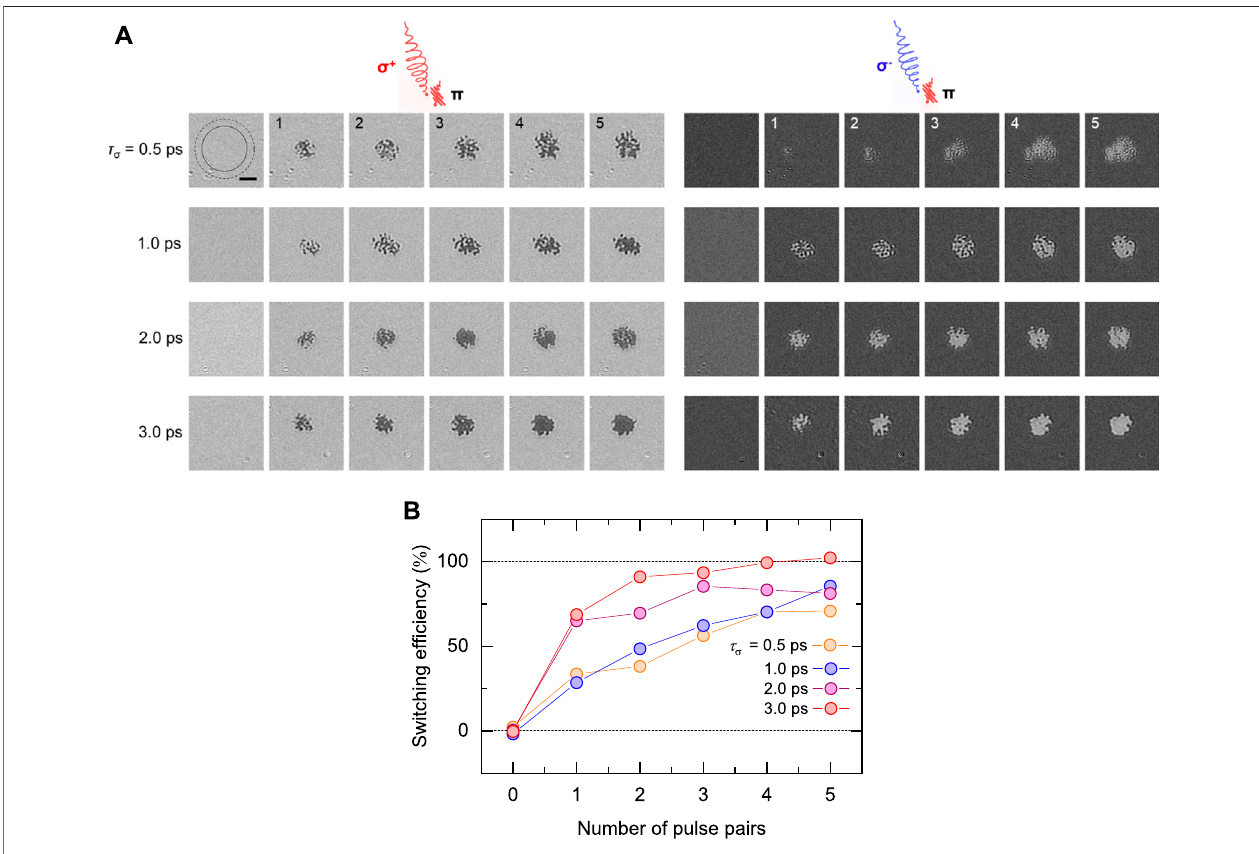
FIGURE2| Thepulsewidth τ σ dependence ofthedual-pulseAO-HDS. (A) Snapshotsbeforeandafterilluminatingtheuniformlymagnetizedsamplewith1-5pairs of pulses at Δ t of 5.0 ps are displayed for τ σ = 0.5, 1.0, 2.0, and 3.0 ps. Here, we used fl uences F π = 2.29 mJ/cm 2 for the π pulse. The fl uences of the σ pulses were F σ = 1.91, 1.95, 1.87, and 1.90 mJ/cm 2 for τ σ = 0.5, 1.0, 2.0, and 3.0 ps, respectively. The 1/e 2 diameter of the σ (solid line) and π (dash line) pulses were 52.0 ± 0.8 and 68.2 ± 1.8 μ m, respectively. The scale bar corresponds to 20 μ m. (B) The switching ef fi ciency as a function of number of pulse pairs for τ σ = 0.5, 1.0, 2.0, and 3.0